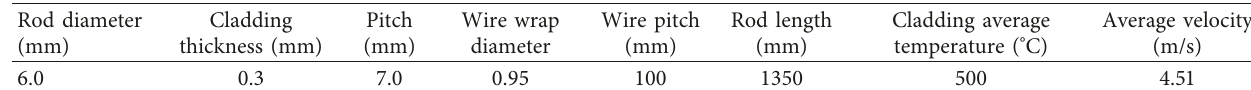
Table 1: Design parameters of the CEFR [10, 11].